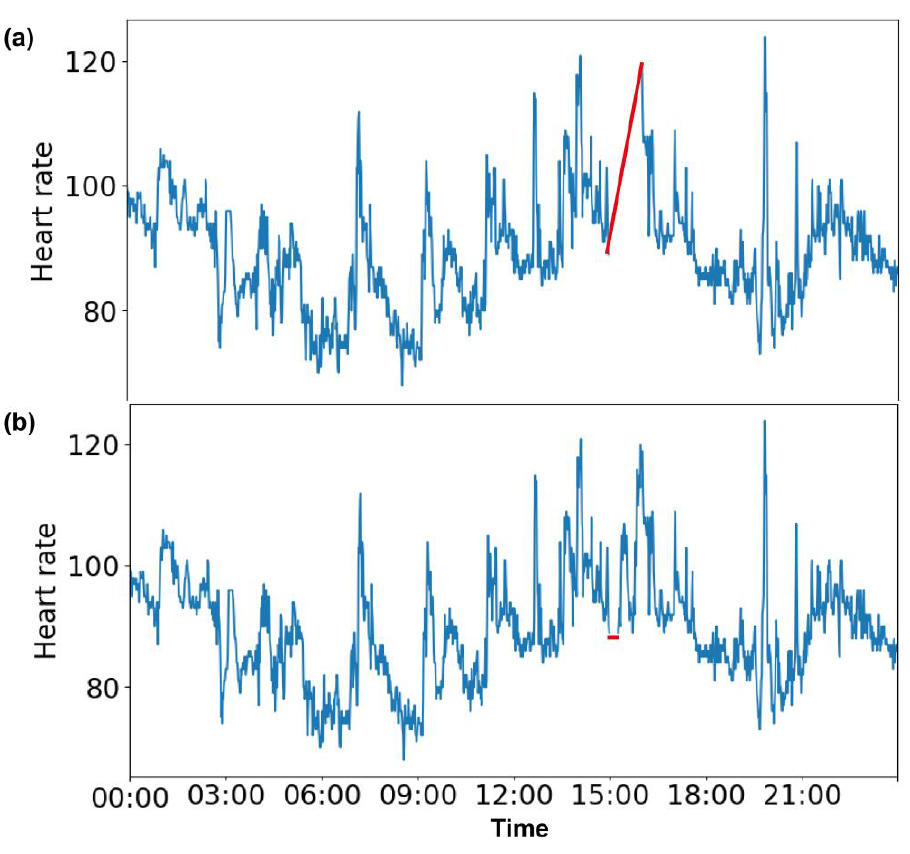
Figure 1. Continuous missing values in heart rate data. Data missing for 1 h from ( a ) 3 pm (15:00 h) to 4 pm (16:00 h) and ( b ) for 15 min from 3 pm (15:00 h) to 3:15 pm (15:15 h) are indicated by red lines.